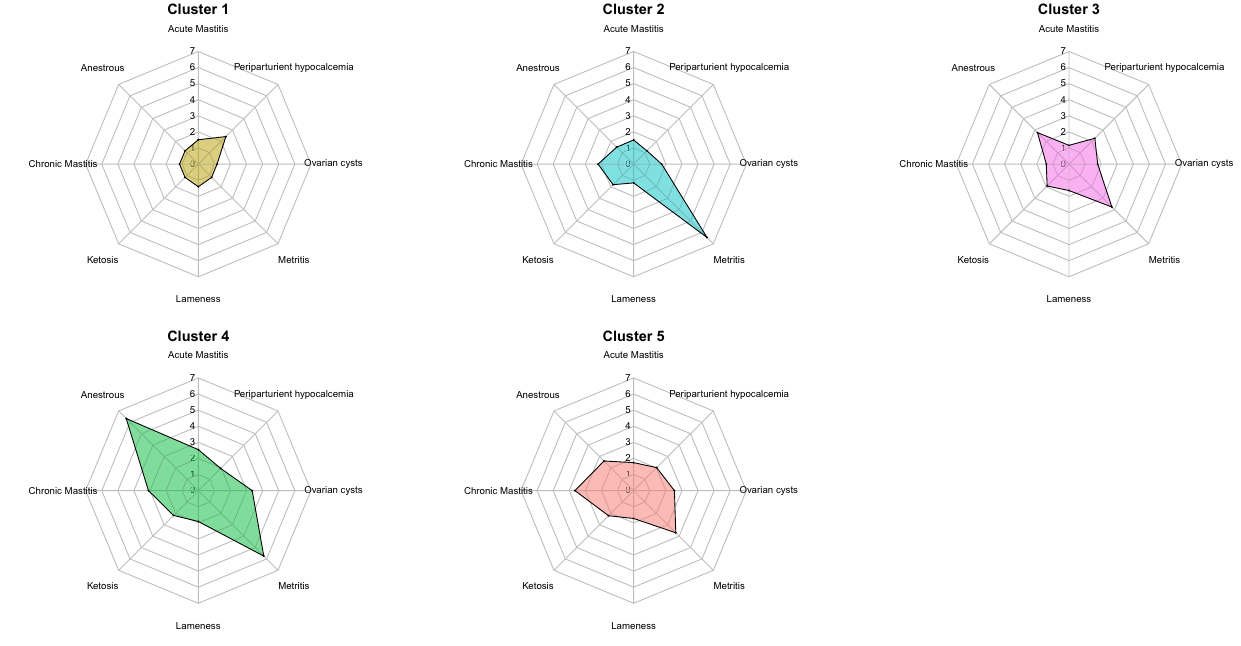
Figure 2. Farm risk profiles. Comparison of the disease frequency in the five clusters. For a given disease, the cluster with the lowest disease prevalence is used as the reference group to calculate the OR of the other clusters. Diagnosis